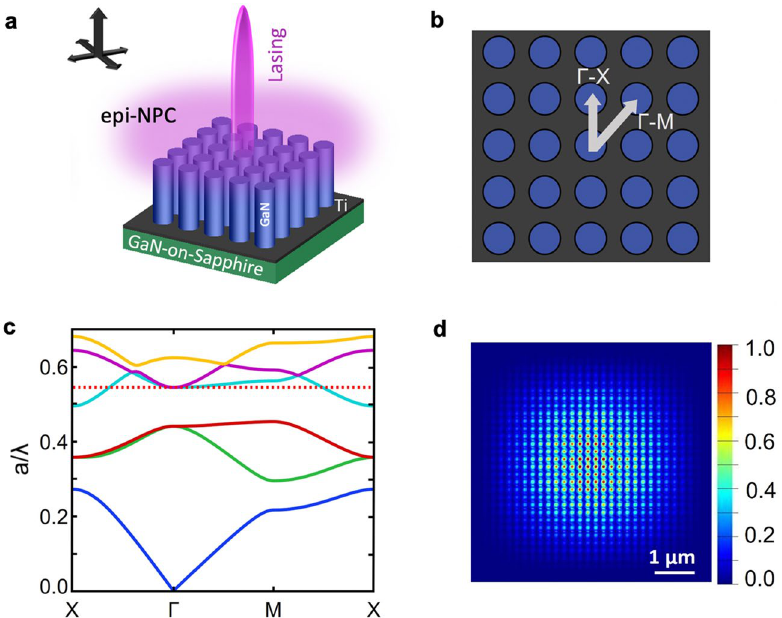
Figure 1. ( a ) Schematic of the UV SE lasing using GaN epi-NPC. Inset: In-plane light propagation and diffraction normal to the plane. ( b ) Top view of the NPC structure, with two specific directions Γ-X and Γ-M labeled. ( c ) Photonic bands of the NPC structure with a = 200 nm and d NW = 173 nm. The red dot line indicates the reduced frequency corresponds to λ ~ 367 nm. ( d ) The electric field profile (| E | 2 ) of the band edge mode calculated by the 3D FDTD